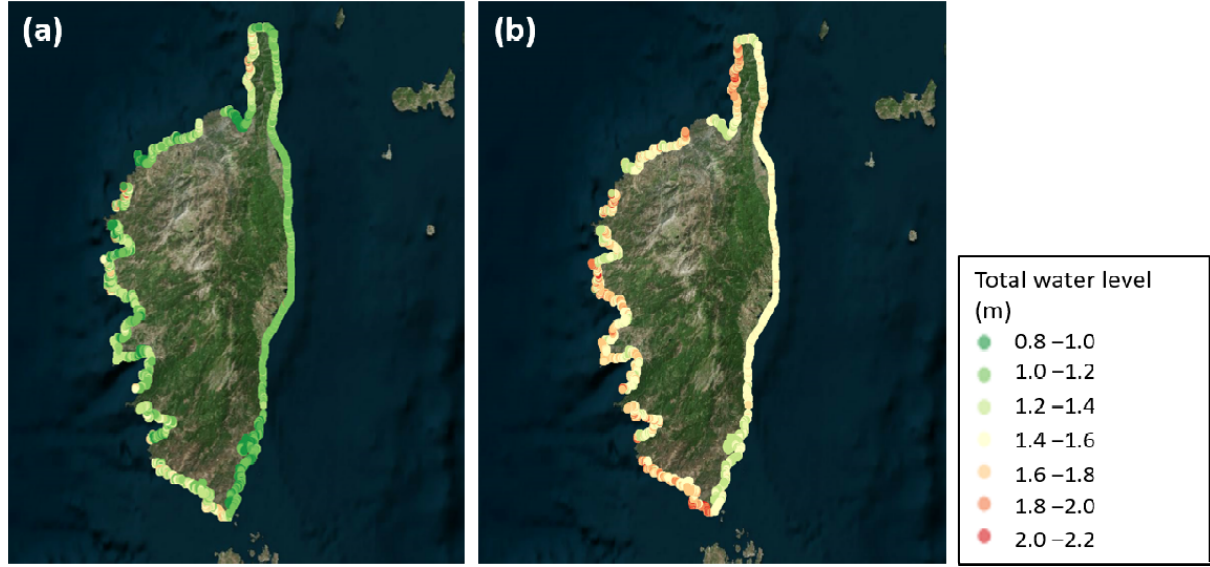
Figure 9. Total water level at the shoreline obtained: ( a ) for current conditions; ( b ) for future conditions (2100).